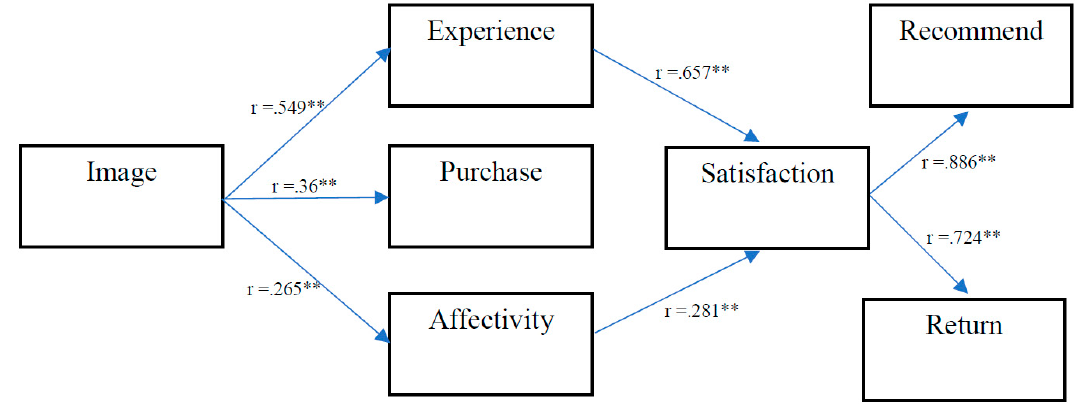
Figure 3. Final conceptual model with the correlations among the variables of the research, based on [15]. Source: Self-elaboration based on data generated by software SPSS.